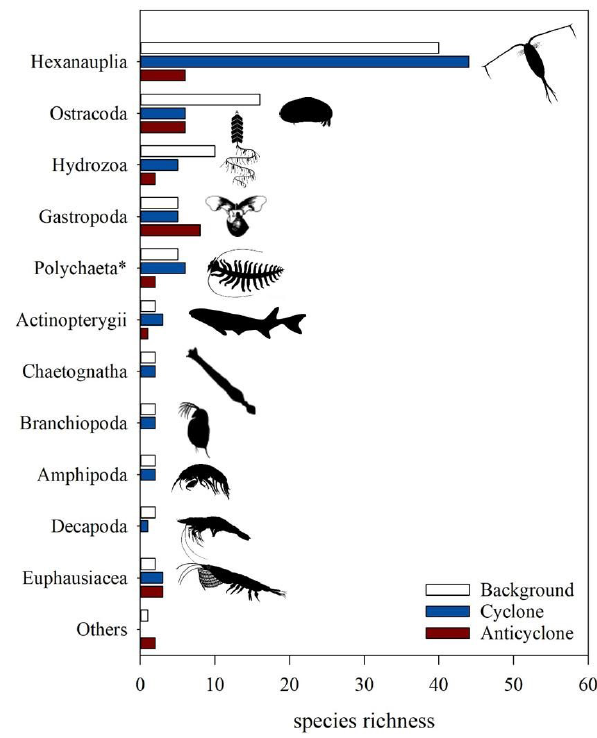
Figure 8. Zooplankton species richness based on COI ampli- con sequences (classified using a BOLD/NCBI-based database) in > 100µm samples collected from the upper 300m of cyclonic and anticyclonic eddies and at an uninfluenced background station in the southeastern Mediterranean Sea during October 2018. Poly- chaeta richness was obtained from rRNA 18S amplicon